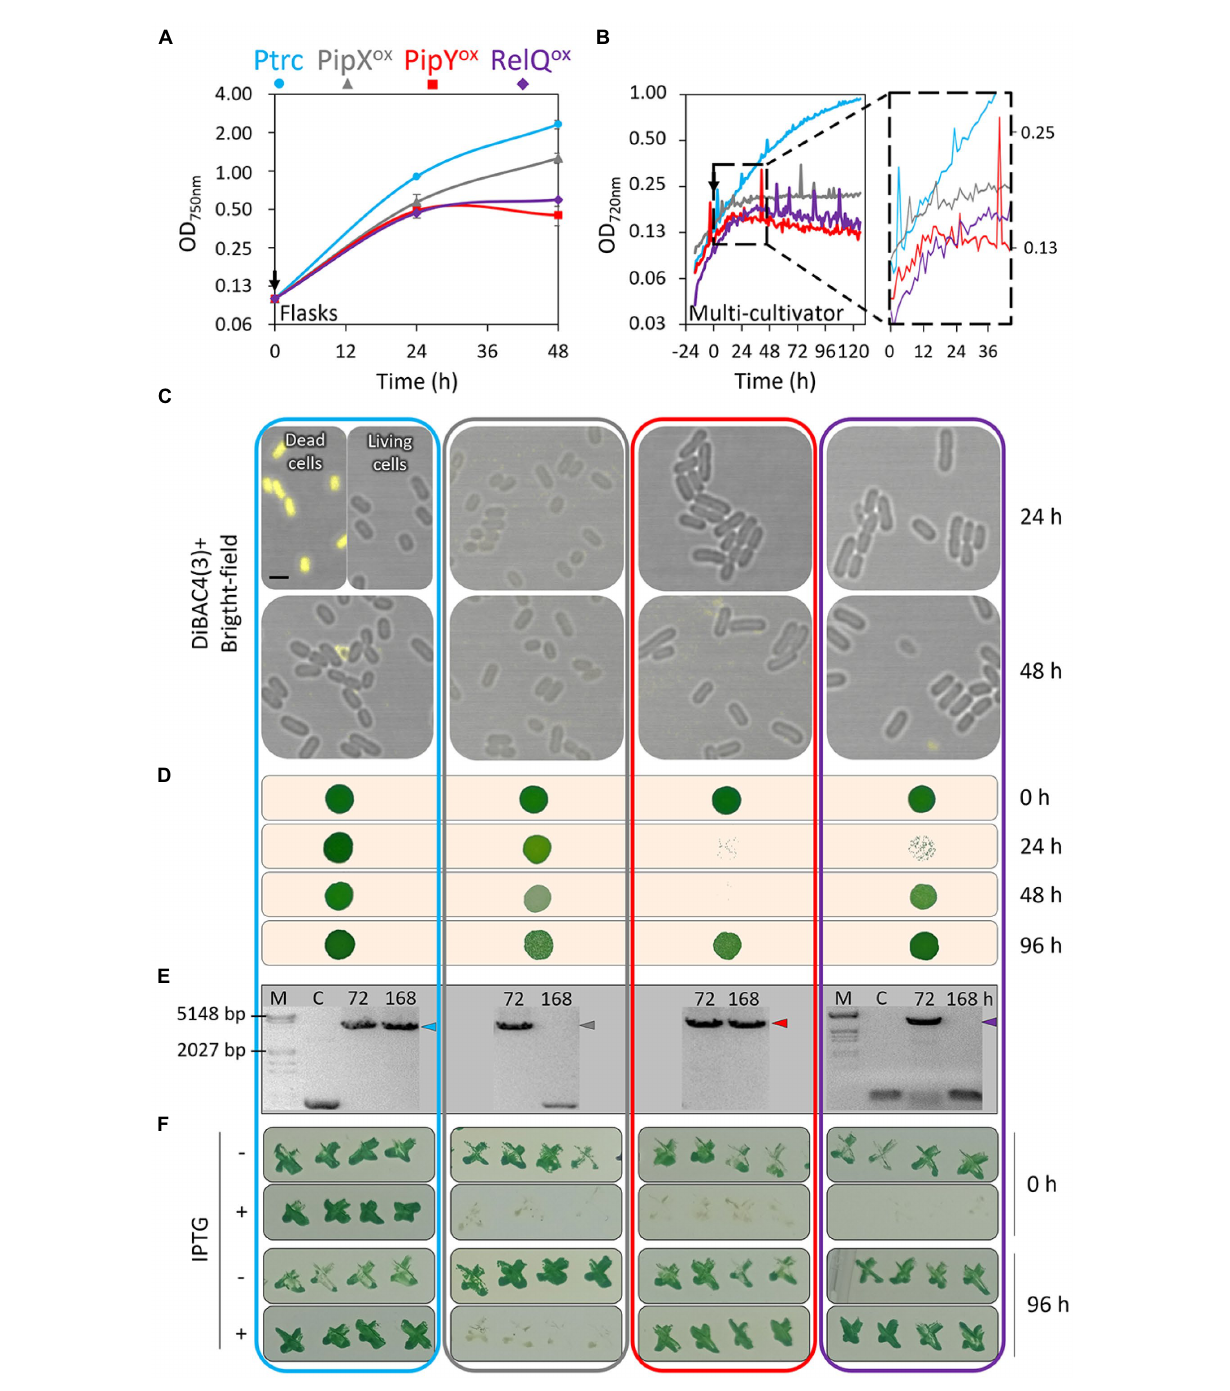
FIGURE 2 Growth-related phenotypes in cultures overexpressing PipX, PipY, or RelQ. Growth curves of the indicated strains in standard culture conditions (BG11 media) with IPTG, measured (A) at OD 750 nm from flasks or (B) at OD 720 nm from a multi-cultivator. The zoom at the inset covers corresponds to the 30 h following IPTG addition, indicated by a black arrow. Data are presented as mean and error bars (standard deviation) of two independent experiments. (C) Representative confocal micrographs showing the overlay of DiBAC4(3) staining (Ex 490–510 nm) and bright-field of cells after 24 or 48 h of IPTG induction. “Dead cells” (only for Ptrc) had been heated for 10 min at 99 ° C before staining. Scale bar, 2 μ m. (D) Drop-plate assay (5 μ L; 0.1 OD 750 ) on IPTG-free medium from IPTG-containing cultures from the indicated timepoints. (E) PCR analyses to verify the stability of overexpression constructs from IPTG-containing cultures from the indicated timepoints. In each gel the colored arrow indicates the band size characteristic of each strain. Reference size bands (numbers) are indicated to the left. M, marker; C, WT control strain. PCR and running conditions were different only for the RelQ ox panel. See Supplementary Figure S1 for additional details. (F) Growth with or without IPTG of crosses from single antibiotic-resistant colonies isolated from cultures at the indicated timepoints of the IPTG treatment. IPTG was always used at 50 μ M. Plate photographs were taken after 5 days. Labels, data points, and panel outlines are colored to indicate the strains as follows: Ptrc-light blue, PipX ox -gray, PipY ox -red, RelQ ox